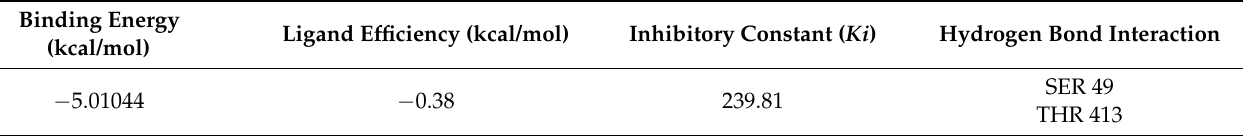
Figure 7. Docking pose of 2-acetamido-2-deoxy-hexopyranose on the binding interaction of PDP. Hydrogen bond interactions indicated by the yellow line. Table 2. Molecular interaction of 2-acetamido-2-deoxy-hexopyranose with the binding pocket of penicillin-binding